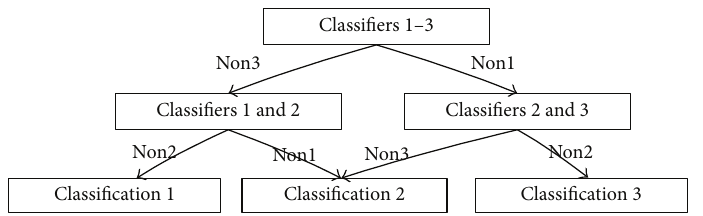
Figure 5: RVM classification graph.